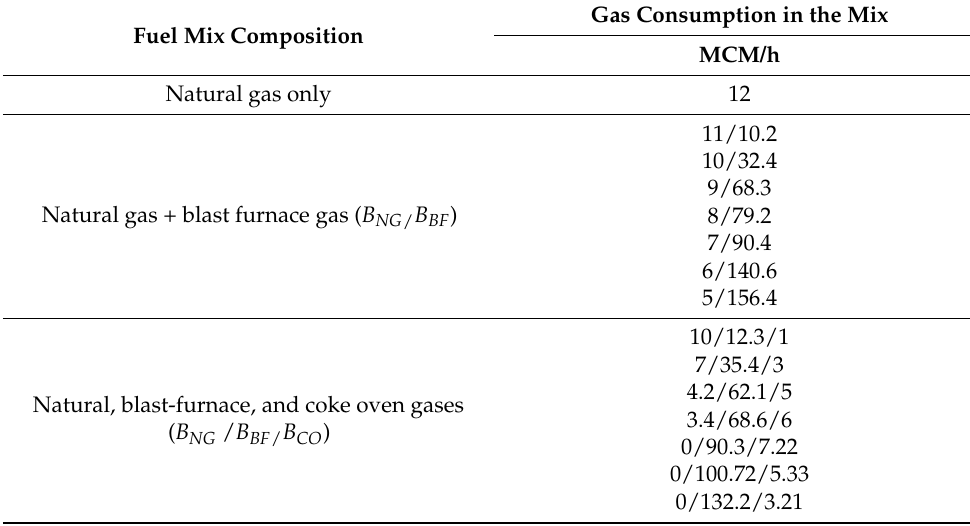
Table 5. Refining the Fuel Mix Composition for a TP-7 Boiler at a Given Steam Capacity of 135 t/h. Gas Consumption in the Fuel Mix Composition